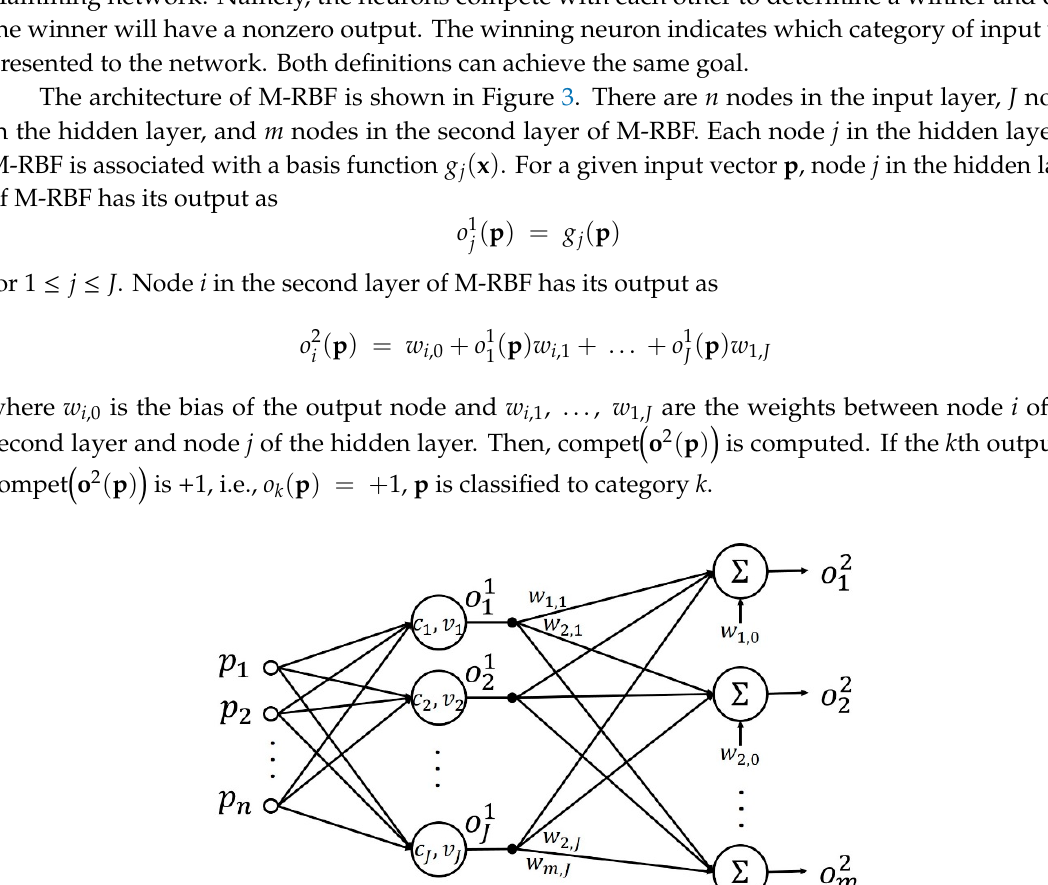
Figure 3. Multi-class radial basis function (RBF) network M-RBF.